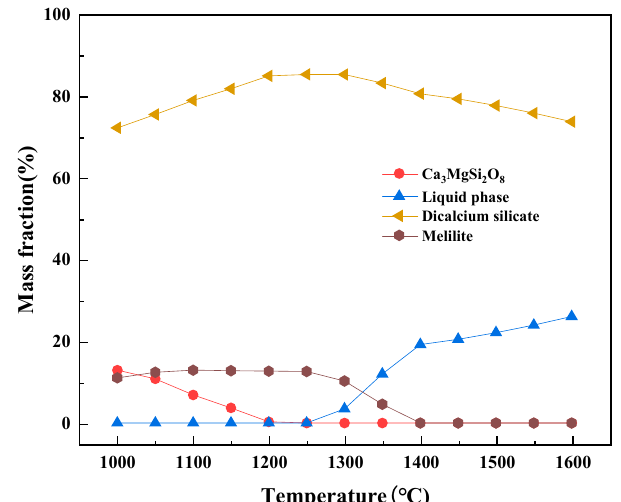
Figure 2. Phase change of magnesium slag.